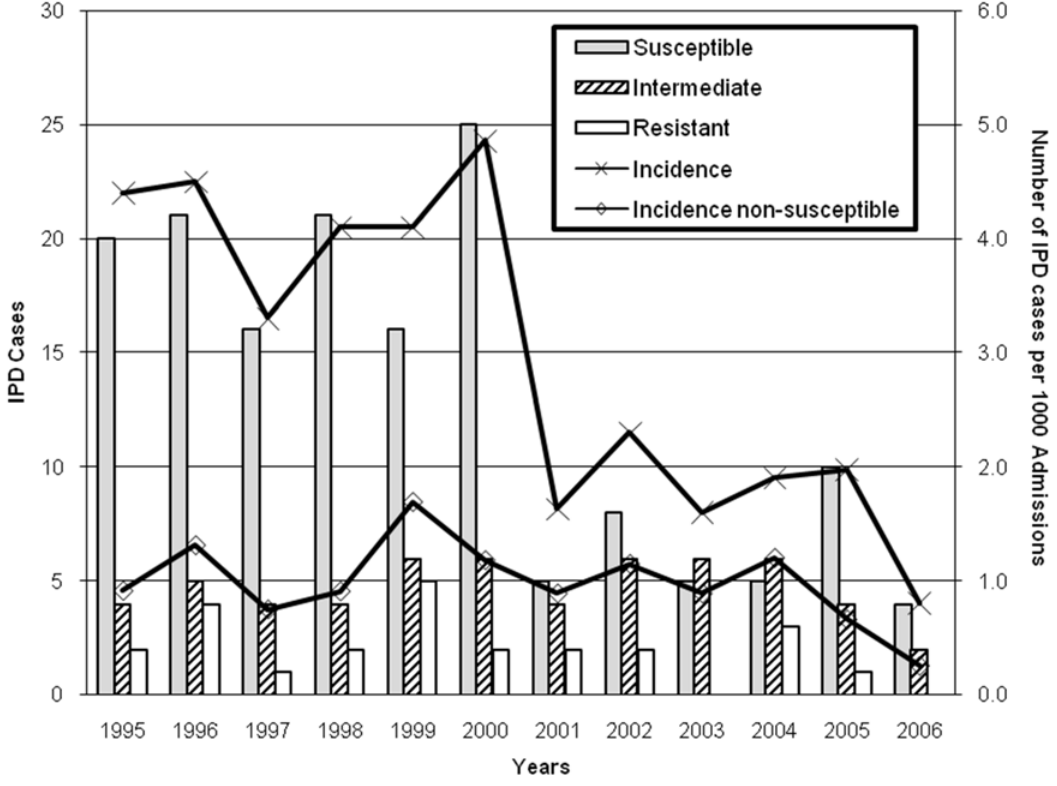
Figure 1. Invasive pneumococcal disease at a NYC Children’s Hospital, 1995–2006. The number of cases of invasive pneumococcal disease (IPD) caused by penicillin resistant, intermediate, and susceptible strains of S. pneumoniae is shown (Left-hand Y axis). The rate of IPD per 1000 admissions and the rate of IPD caused by penicillin non-susceptible strains per 1000 admissions are shown (Right-hand Y-axis). doi:10.1371/journal.pone.0005965.g001 PLoS ONE |